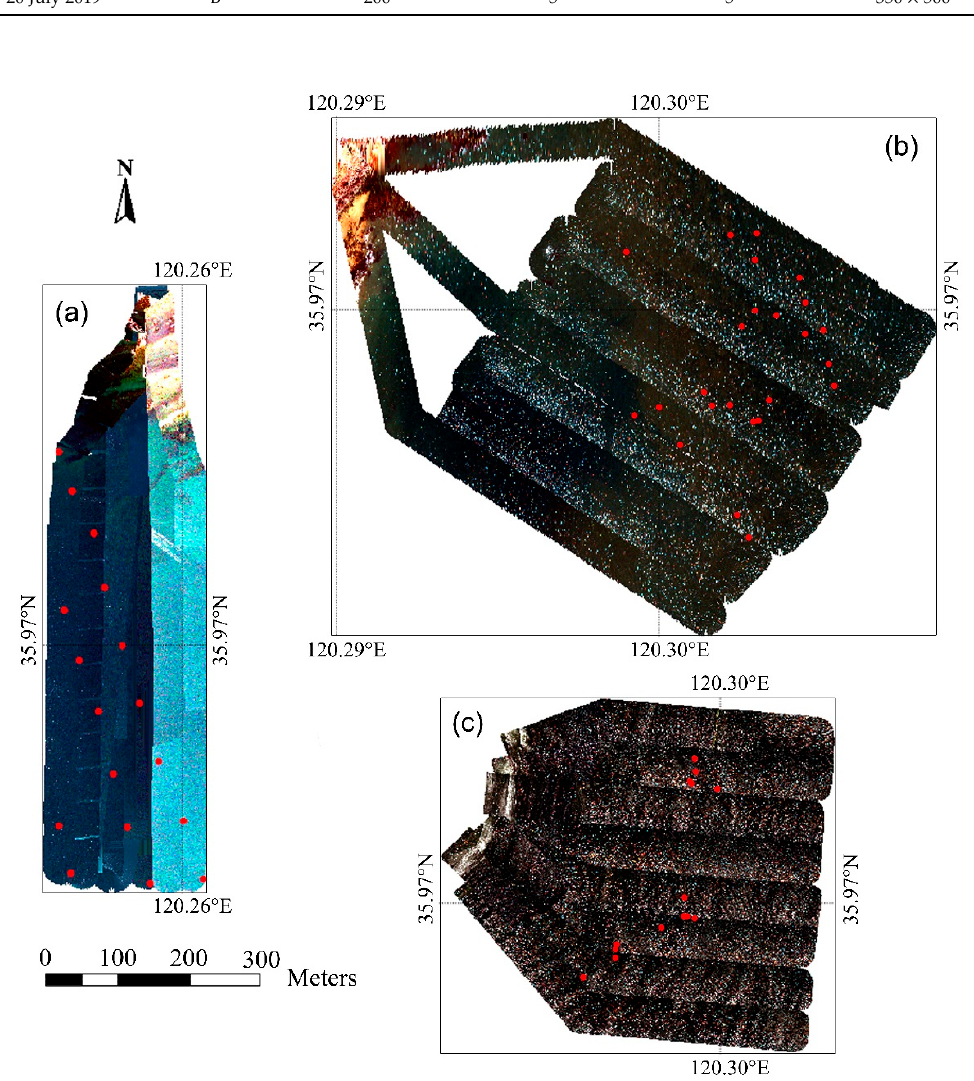
Figure 3. Hyperspectral true color synthesis images of sea surface after preprocessing on ( a ) 17 December 2018, ( b ) 22 March 2019, and ( c ) 20 July 2019. Red dots denote water sampling sites, and the red box denotes the fifth flight on 17 December 2018.